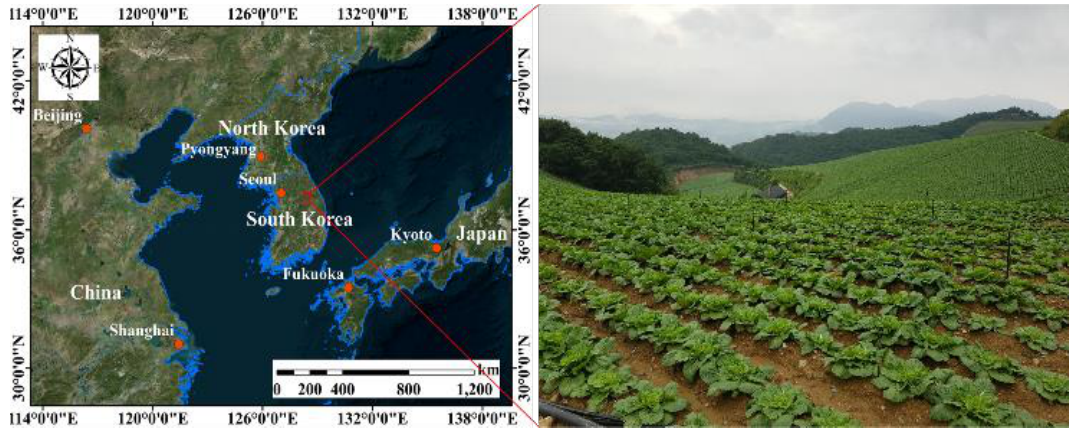
Figure 1. Location map and cultivation status of the study area.